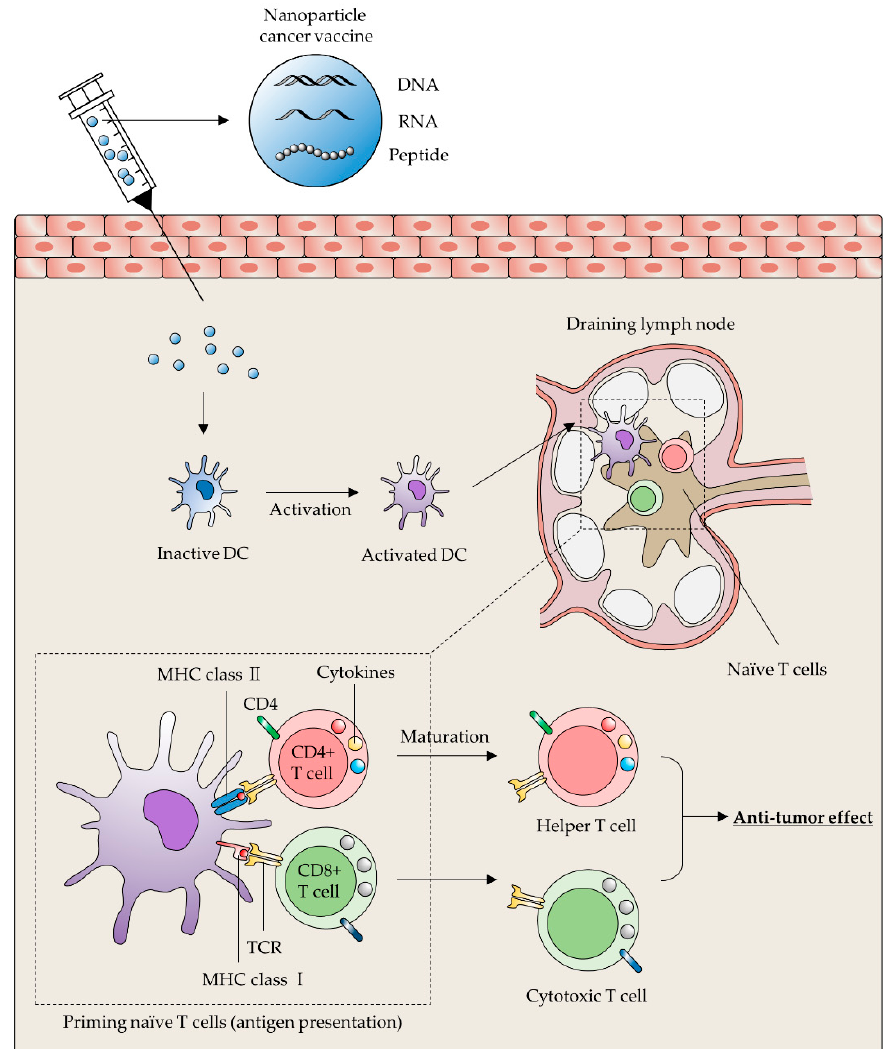
Figure 2. Schematic illustration presenting brief mechanism of DC-based cancer vaccine. After vaccination with TAA-related payloads encapsulating NPs, TAA can be delivered into DCs and processed. Naïve T cells (CD4+/CD8+) are primed through presented TAA peptides on MHC I/II molecules of activated DCs. Naïve CD4+/CD8+ T cells differentiated to the Th cell and Tc cell respectively. Functional Th and Tc cells attack specific tumor cells expressing TAA presented by DCs.